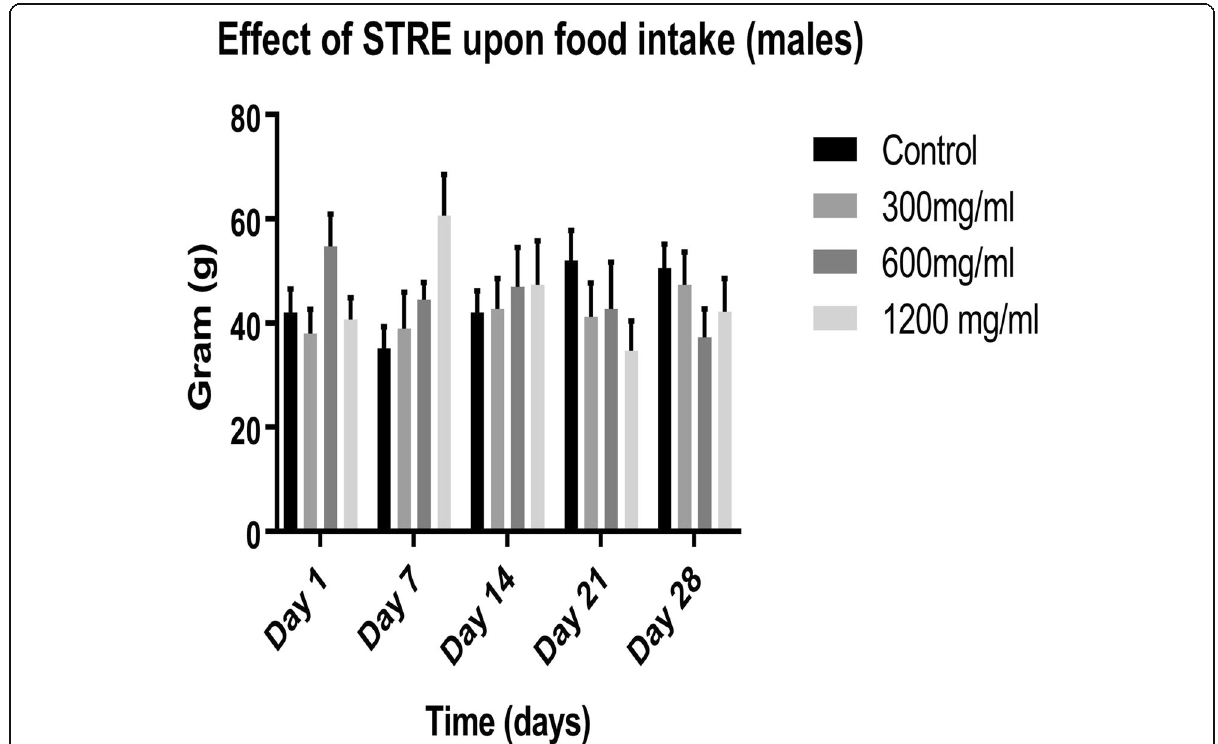
Fig. 5 Effect of STRE on food intake of male subjects. Values are expressed as mean ± SEM Statistical significance (p) calculated by one way ANOVA followed by dunnett ’ s ( n =